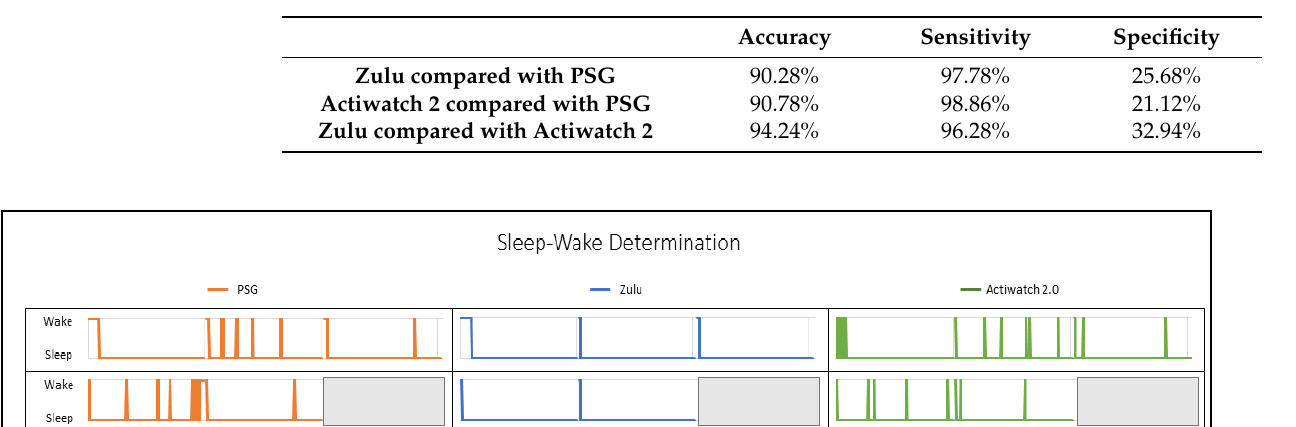
Sensors 2021 , 21 , x FOR PEER REVIEW 7 of 18 3. Results